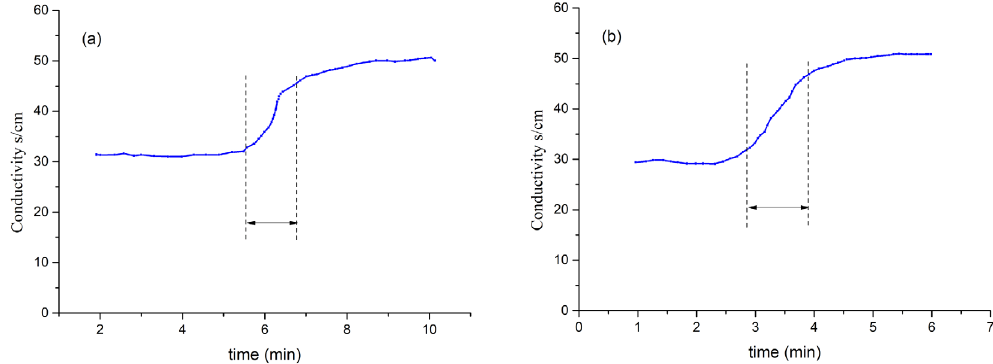
Fig. 3. (a) The response time required for the tracer injected into the pot to achieve the distillate accumulator. (b) The required time for the tracer that injected in the distillate accumulator to achieve the still pot.